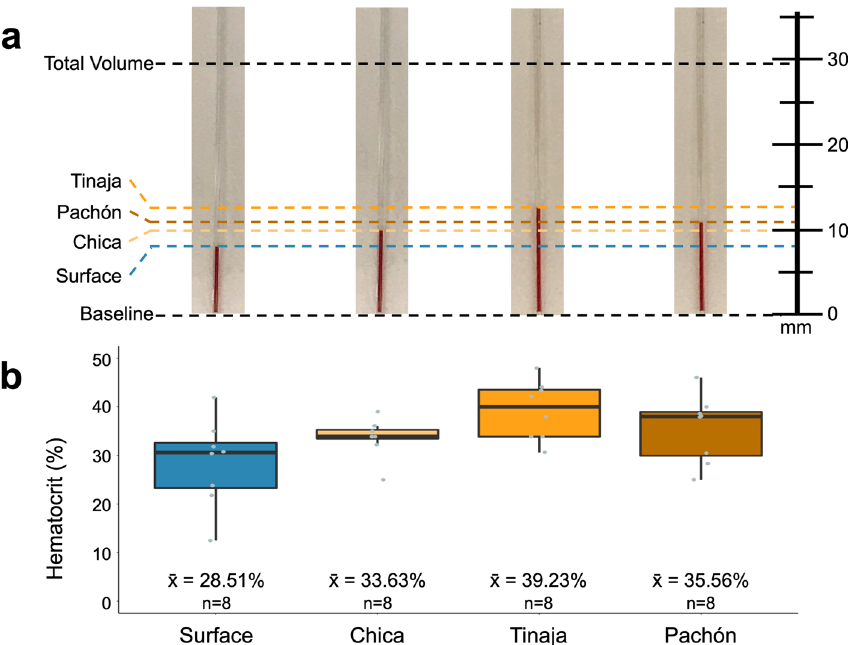
Figure 2. Hematocrit trends higher in cavefish than surface fish. The fraction of red blood cells to total blood volume (hematocrit) was determined via centrifugation of microcapillary tubes. The erythrocytic phase collects at the distal end of the capillary tube while the buffy coat and plasma collect more proximally ( a ). Although statistical significance was not achieved when comparing populations individually, (compared to surface; Chica WRS p = 0.115, Tinaja WRS p = 0.018, Pachón WRS p = 0.161), a clear trend of higher hematocrit was noted for each cavefish population compared to surface ( b ). When comparing by morphotype (surface against all cavefish), however, cavefish do have a statistically significant higher mean hematocrit (surface n = 8, mean = 28.51 ± 0.03%, Cave n = 24, mean = 36.14 ± 0.01%, WRS p = 0.024) than surface fish. One outlier (the lowest Chica value) was detected although statistical significance was unchanged (Table